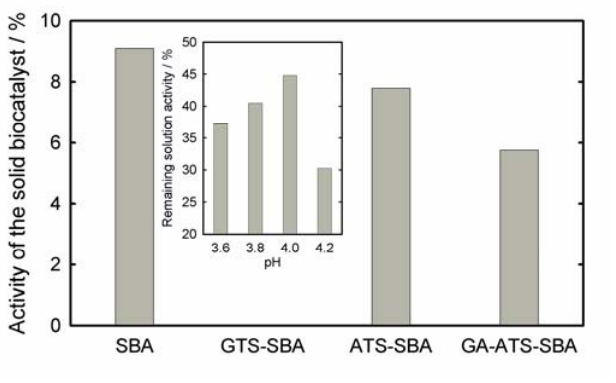
Figure 6. Activity of the covalent immobilized chloroperoxidase on SBA-15 and modified materials expressed in percent of the initial solution activity (pH = 3.8). Insert: covalent immobilization of chloroperoxidase over GTS-SBA-15. Activity values are given in percent of initial CPO activity as determined by the MCD assay (see Section 3.2).